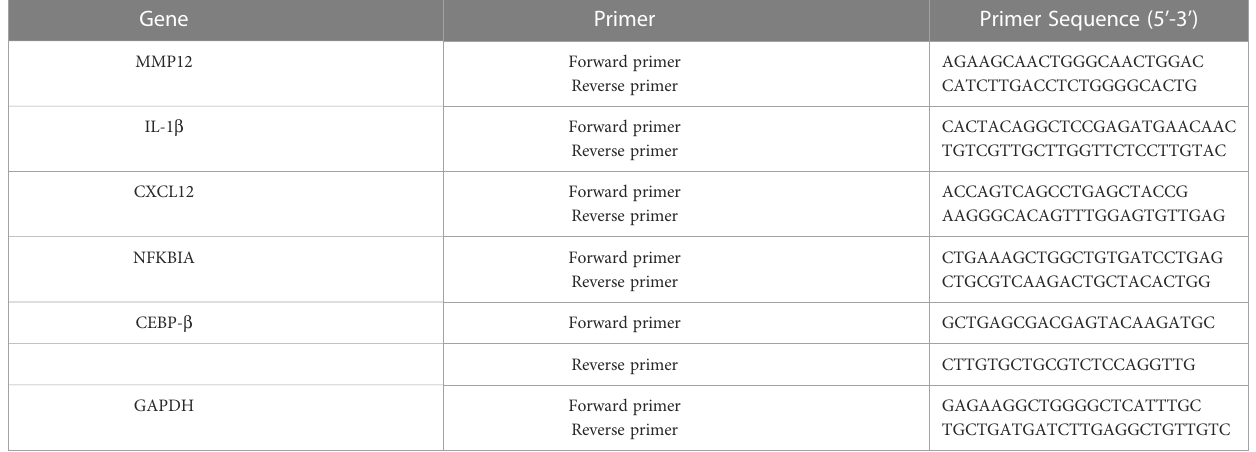
TABLE 1 Primers of reverse transcription PCR analysis for